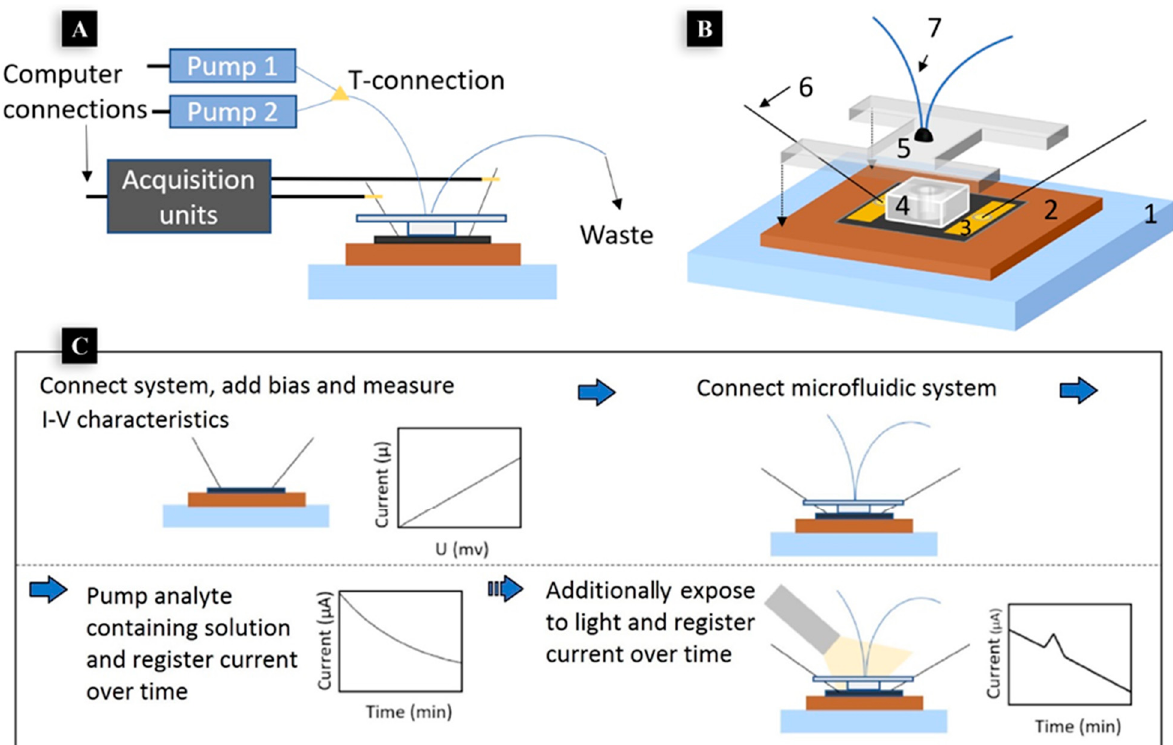
Figure 4. ( A , B ), at the top, show an overview of the setup and all connections and the schematic of the setup with all essential components marked. 1: stage; 2: holder; 3: fabricated graphene-based device; 4: PDMS-based flow chamber; 5: PMMA lid; 6: needle pin probes; 7: microfluidic tubing. General scheme for the detection of different analytes with the fabricated graphene-based device including additional exposure to light to investigate the discovered photo-physical response illustrated in the box at the bottom ( C ). Adapted with permission from ref. [85]. Copyright 2019